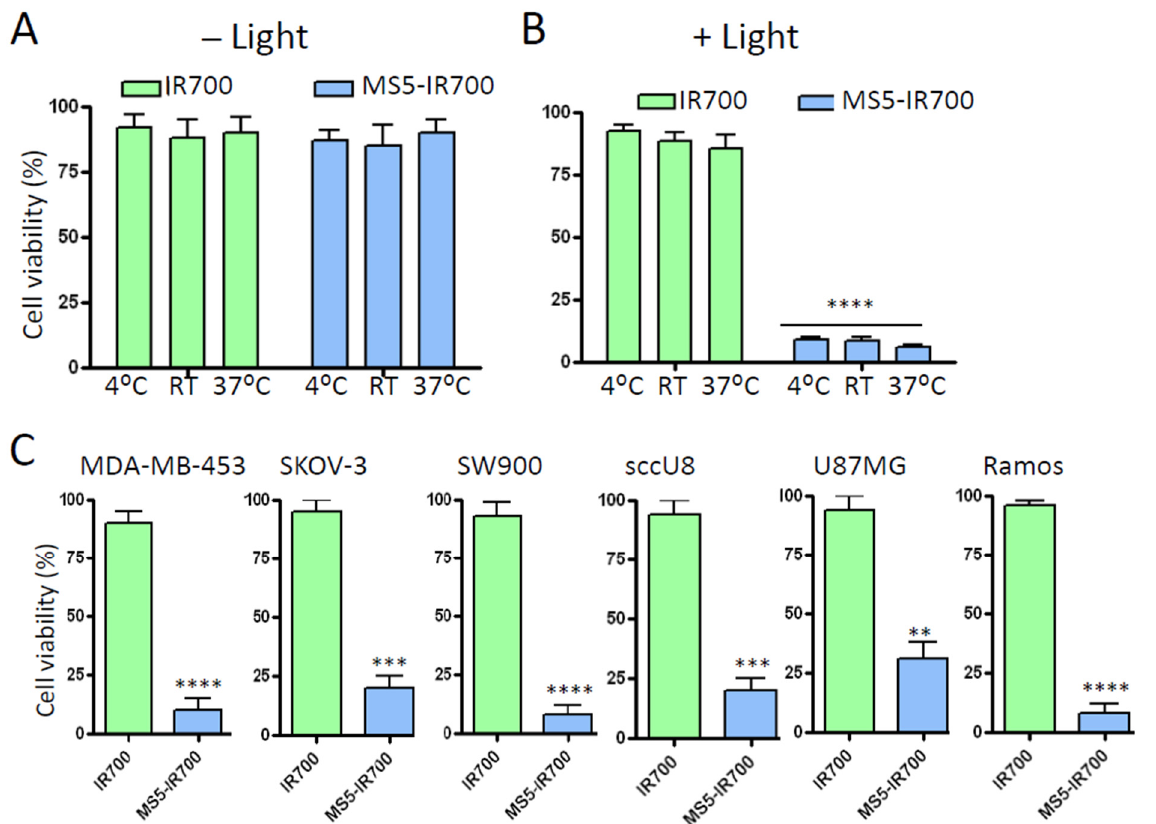
Figure 5. Cell killing does not require antibody internalization. ( A ) PC3 cells were incubated with IR700 (50 nM) or MS5-IR700 conjugate (5 µ g/mL) at either 4 ◦ C, RT or 37 ◦ C for one hour. After washing, the cells were not ( A ) or exposed ( B ) to light (35 J/cm 2 at a power density of 17 mW/cm 2 ) and then incubated at 37 ◦ C. After 16 h incubation, cell viability was measured by MTS assay. ( C ) Effects of the conjugate on other malignant cells. Conditions are as in A, except that the incubation with the test molecules was done at RT. Data are expressed as a percentage of the control cells (untreated) and are from triplicate determinations. They are representative of 3 independent experiments. ** p < 0.01, *** p < 0.001, **** p < 0.0001.